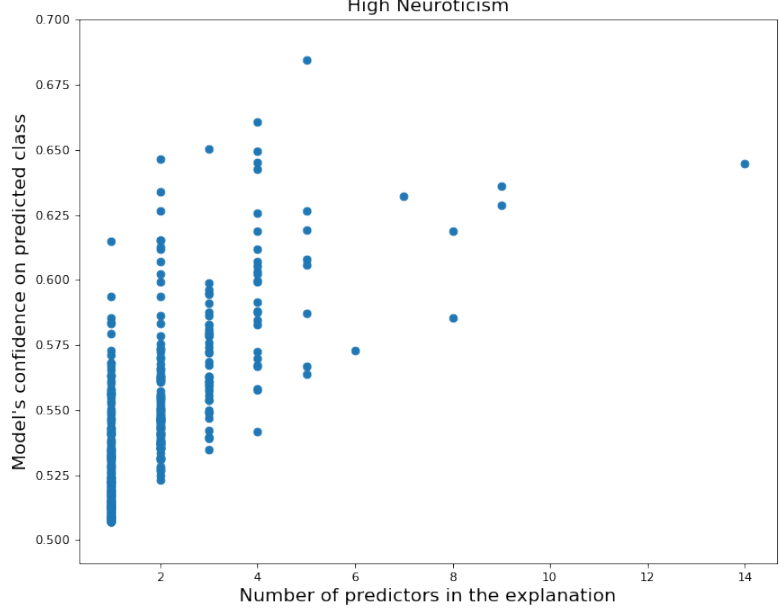
Figure 8. Model’s predicted scores vs. number of predictors in the explanation to counterfactually explain the predicted class High Neuroticism. The correlation between the scores and explanation sizes is